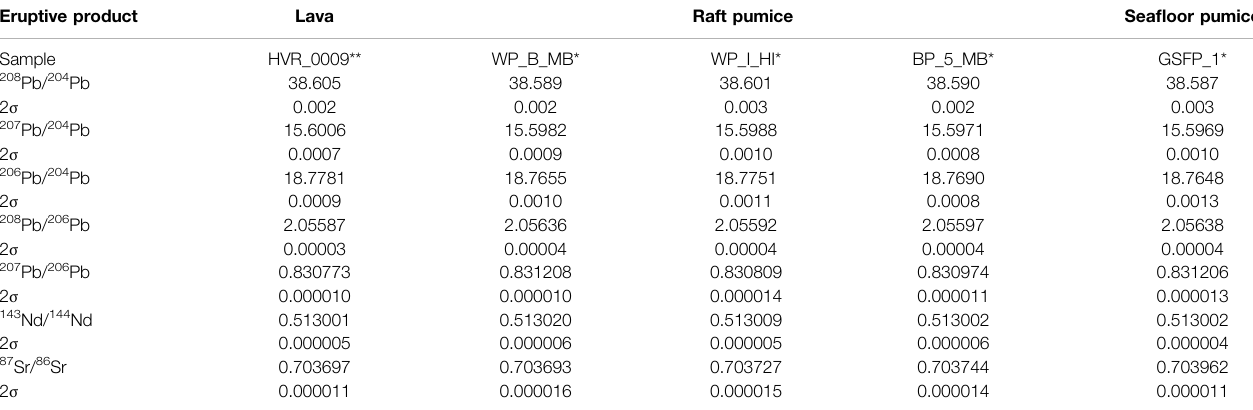
TABLE 2 | Pb, Sr, and Nd isotope ratios of three raft and one sea fl oor pumice samples (*) and a single 2012 Havre lava glass (**), with the respective uncertainties (2 sd) reported.